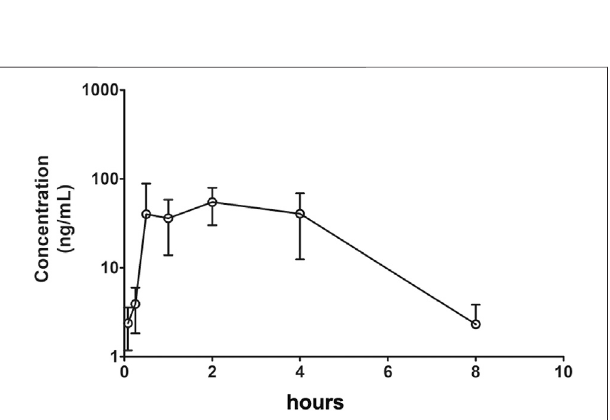
FIGURE 2 | Plasma concentration – time pro fi les after intravenous administration of Indo5 (1 mg/kg) in rats ( n (cid:2) 3). Data are presented as the mean ± SD.